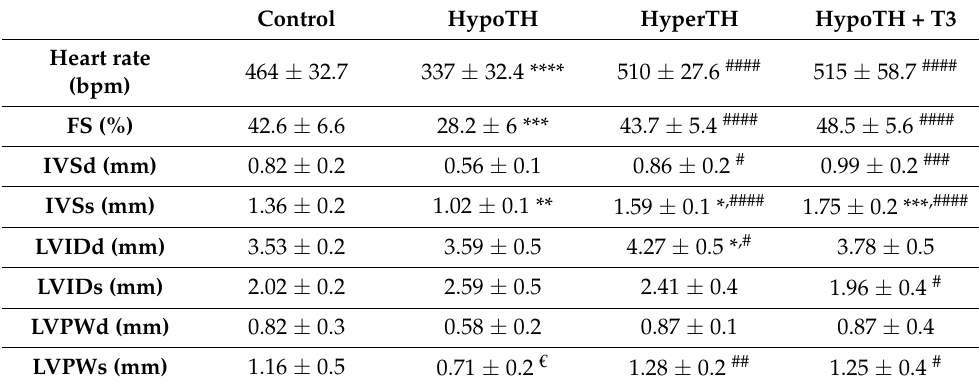
Table 1. Echocardiogram shows preserved cardiac function following TH